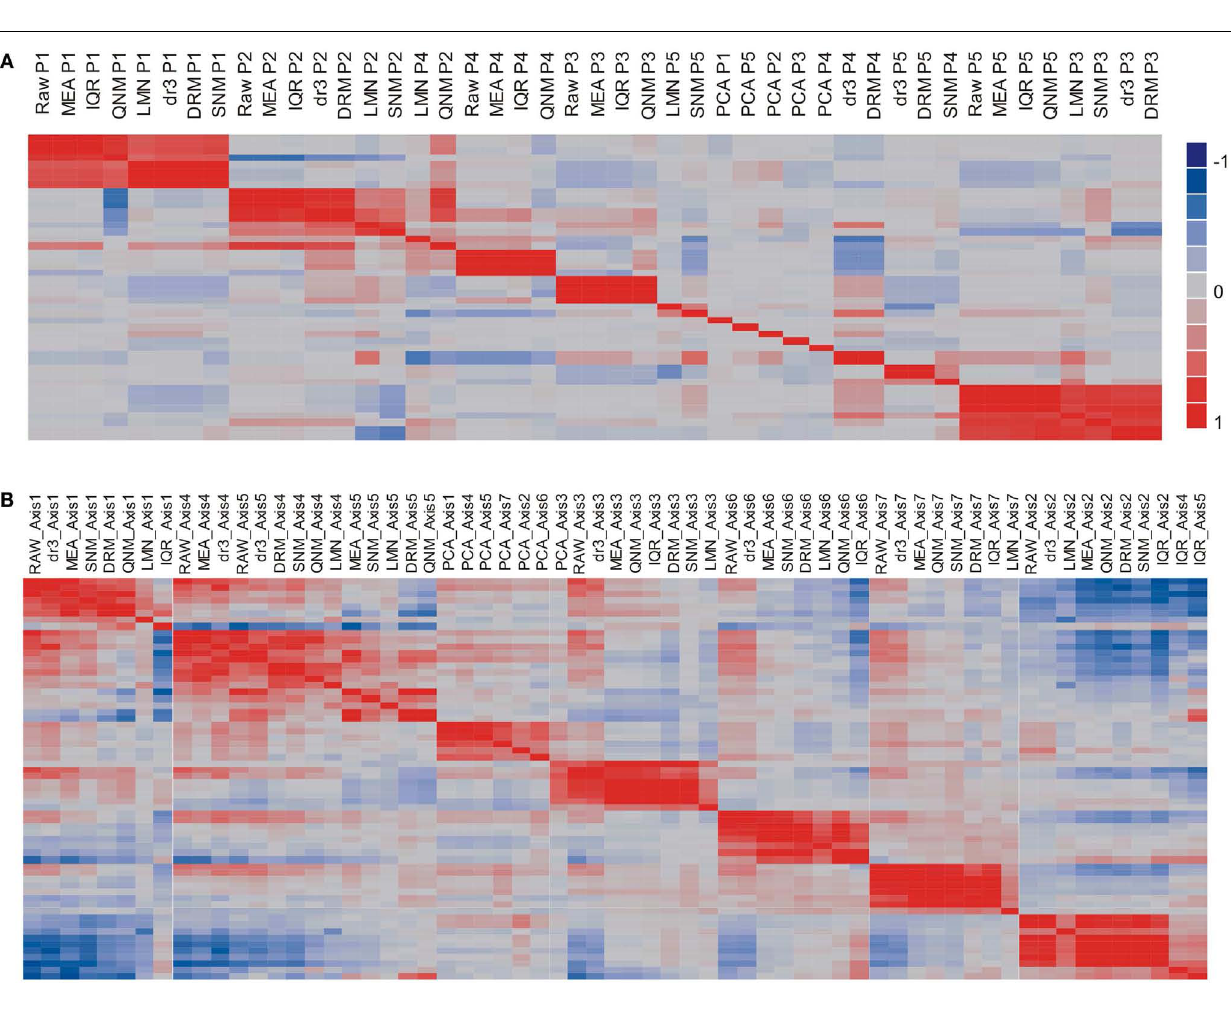
FIGURE 3 | Similarity of principal components (A) and immuno-informative axis scores (B). The heat maps show the correlation coefficient across all 189 samples for each PC axis, where the order of the rows is the same as the order of the columns. (A) Comparison of the first five PC shows that PC1 is generally highly correlated across normalization